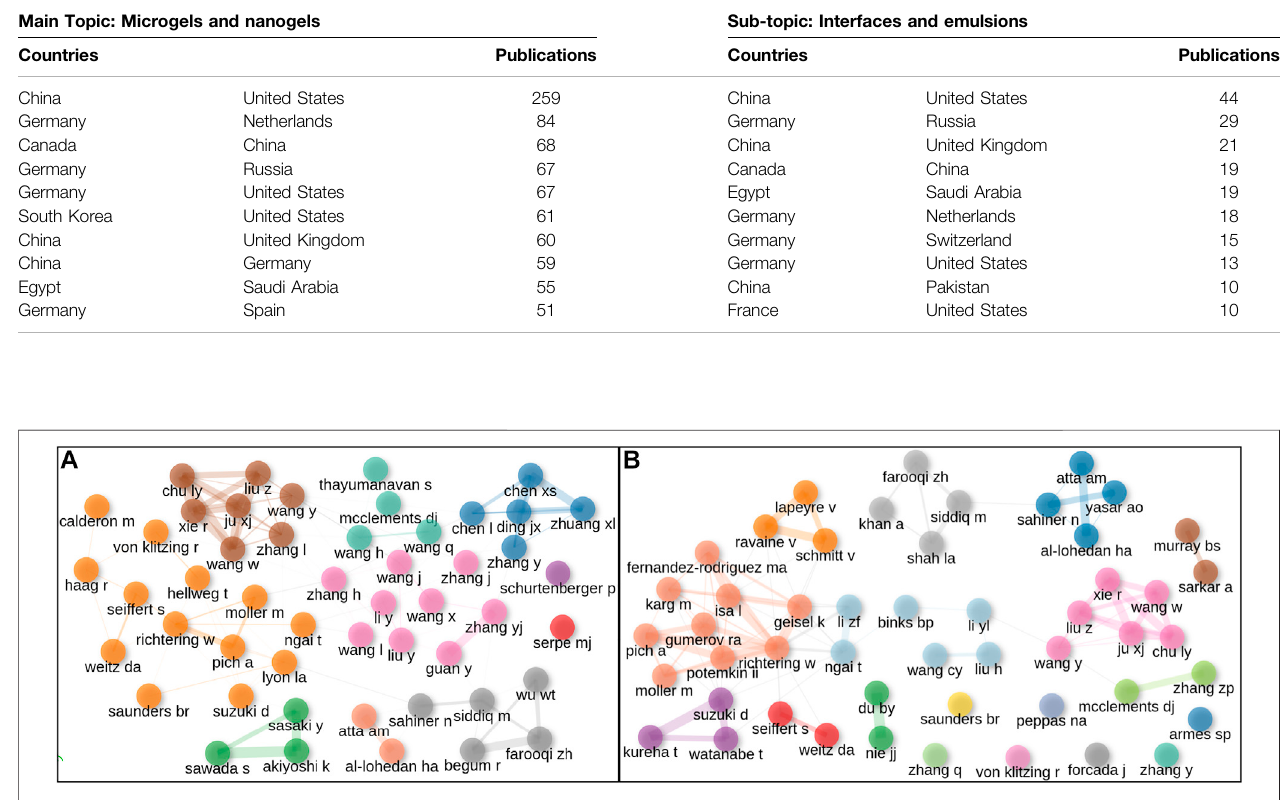
TABLE 1 | Collaboration network of the main topic and sub-topic by countries. Table showing the collaboration for the main topic “ microgels and nanogels ” and the sub- topic “ microgelsandnanogelsatinterfacesandemulsions ” .Constructedfromthe10morefrequentcollaborationsbasedonpublicationsbetweeninternationalresearch groups, restricted to the years 2010 – 2020. Countries are sorted in each row by alphabetic order.